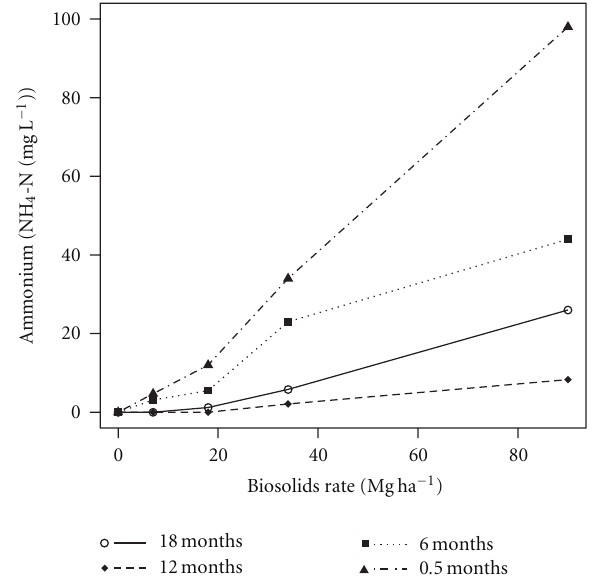
Figure 10: Orthophosphate, PO 4 − 3 -P, in runo ff water from Stellar soils as a ff ected by postapplication age (18, 12, 6, or 0.5 months) and biosolids application rate (redrawn from [15]).